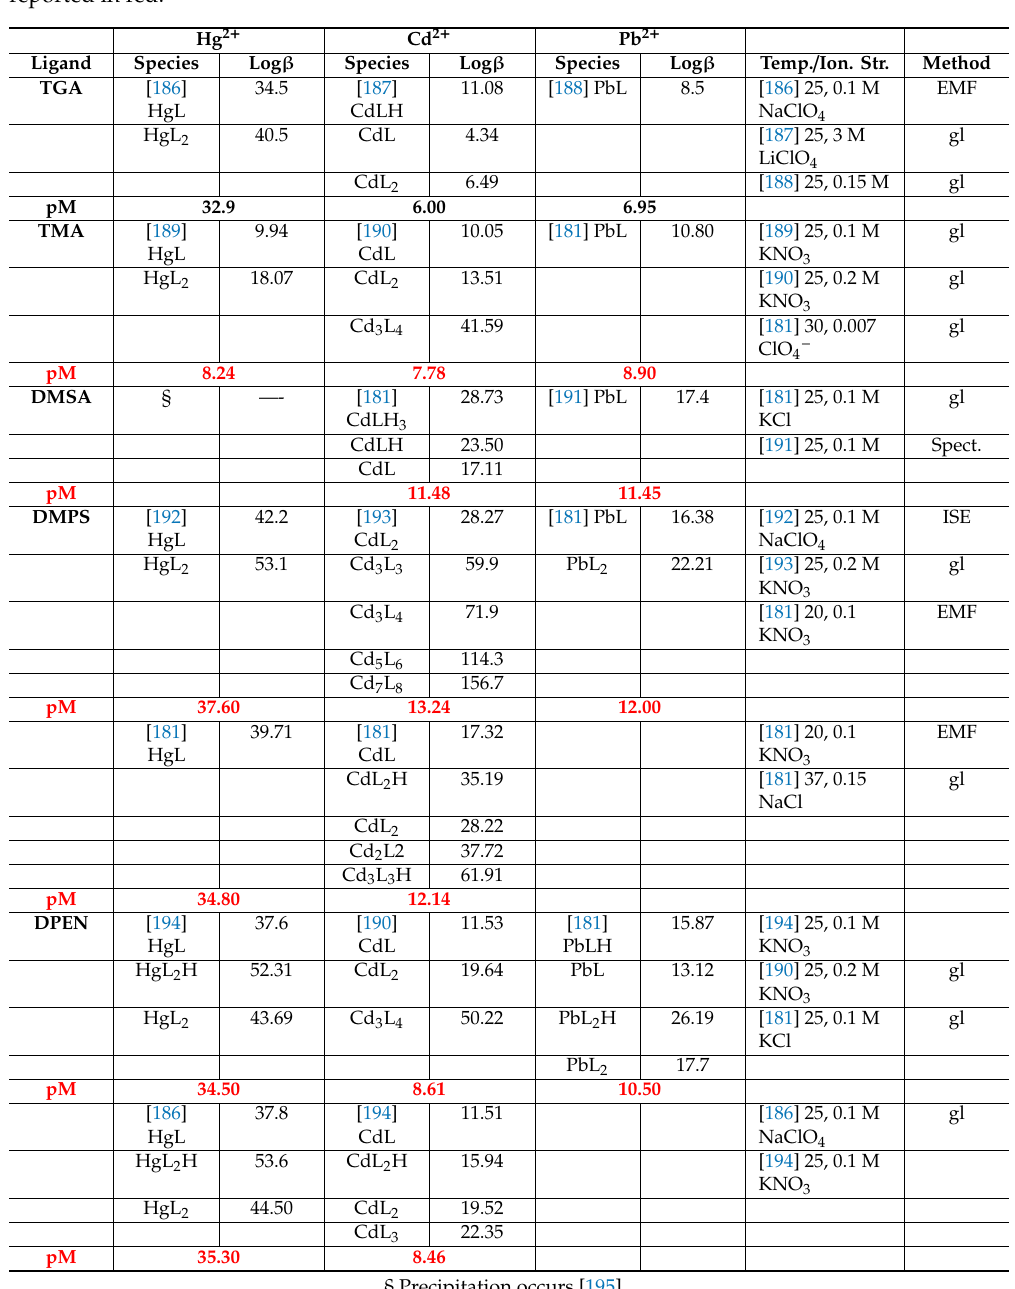
Table 4. Complex formation constants of thioglycolic acid, thiomalic acid, DMSA, DMPS, penicillamine, lipoic acid, dihydrolipoic acid with Hg 2 + , Cd 2 + , and Pb 2 + . The pM values for each system are also reported in